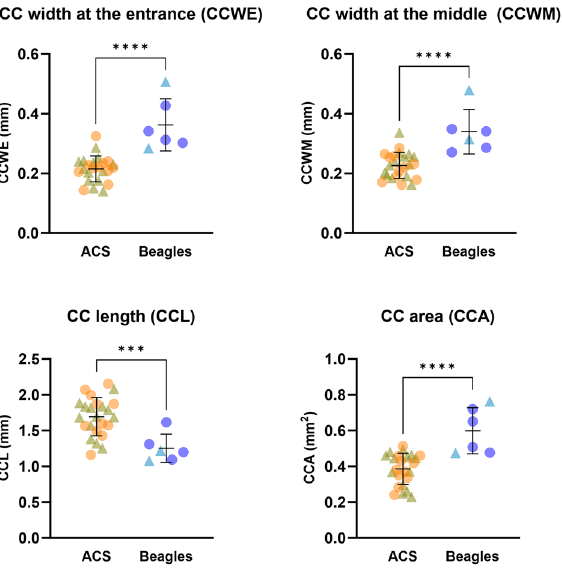
Figure 3. The ciliary cleft (CC) of ACSs was significantly more narrow than that of Beagles. While the CC length (CCL) was significantly longer in ACS, the CC width at the entrance and the middle (CCWE and CCWM) were significantly shorter resulting in a significantly smaller CC area (CCA). An unpaired t -test was performed (n = 24 ACS and 6 Beagles; *** = p value < 0.001; **** = p value < 0.0001). The line and error bars indicate mean values and standard deviations. The circles and triangles indicate females and males, respectively.